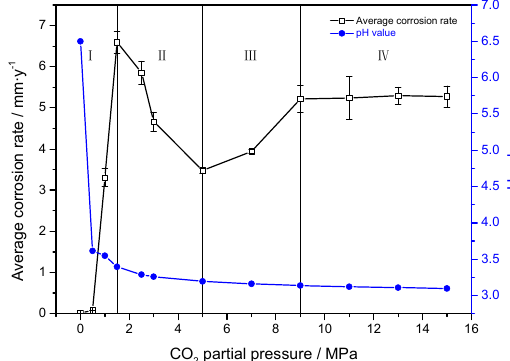
Figure 14. Average corrosion rate and estimated pH value as a function of CO 2 partial pressure in 30% crude oil/brine mixtures.